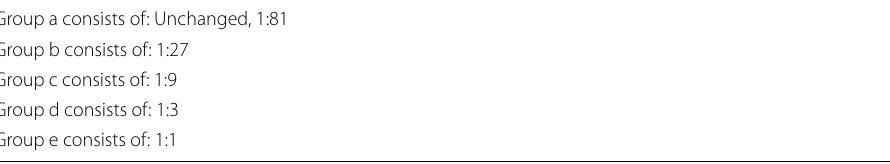
Table 16 HSD test groupings after ANOVA of AUPRC for the RUS factor